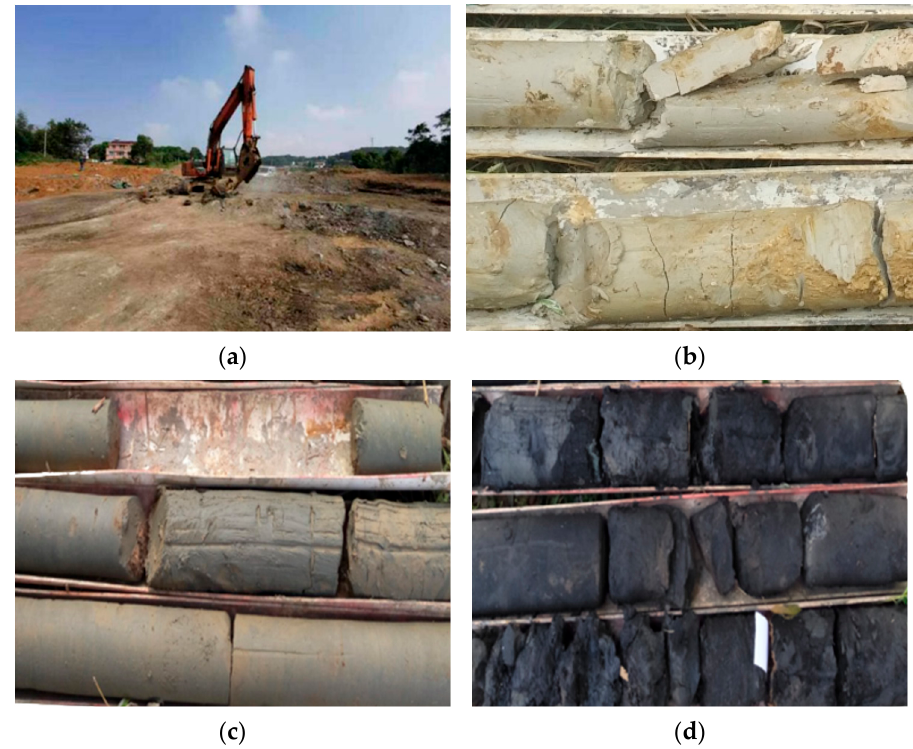
Figure 1. Test section site and three types of diatomaceous earth: ( a ) test site; ( b ) white diatomaceous earth; ( c ) blue diatomaceous earth; and ( d ) black diatomaceous earth.